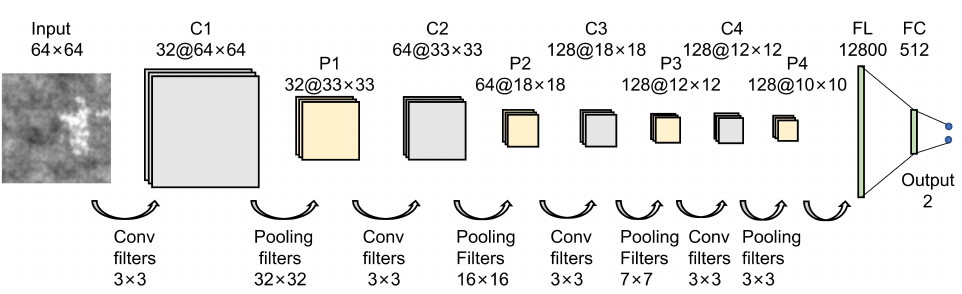
Figure 5. Into patches and then sent to the two models for judgment.